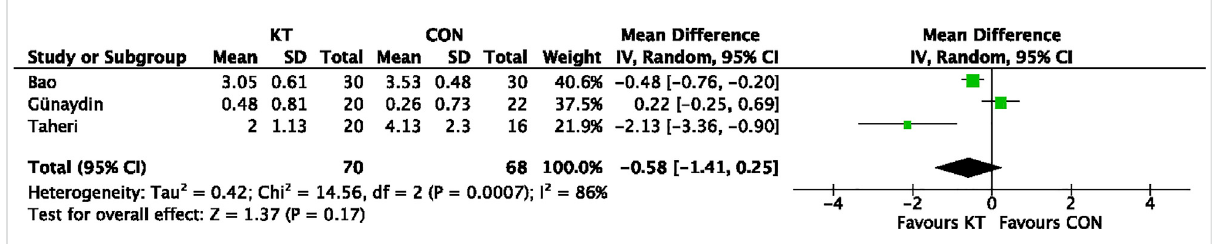
FIGURE 6 Forest plot of the meta-analyses comparing the KT group with control group for VAS score at follow-up period.